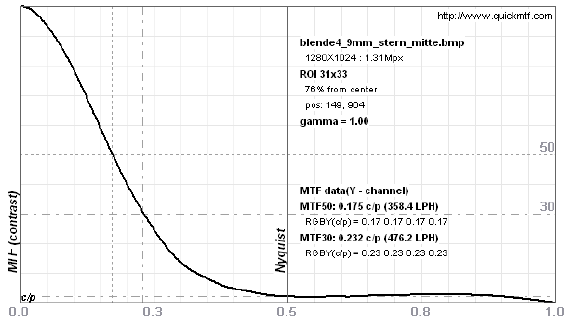
Figure 10: MTF of Crevis a the image center (f-stop 4,0)